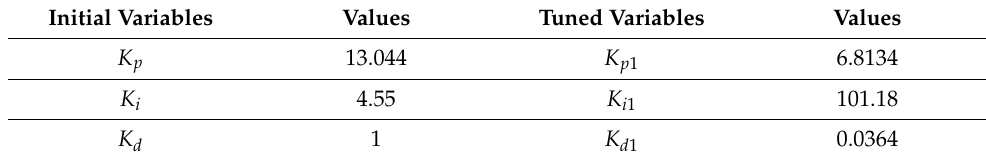
Table 1. Initial parameters of K p , K i , and K d and tuned parameters of the PID controller. Initial Variables